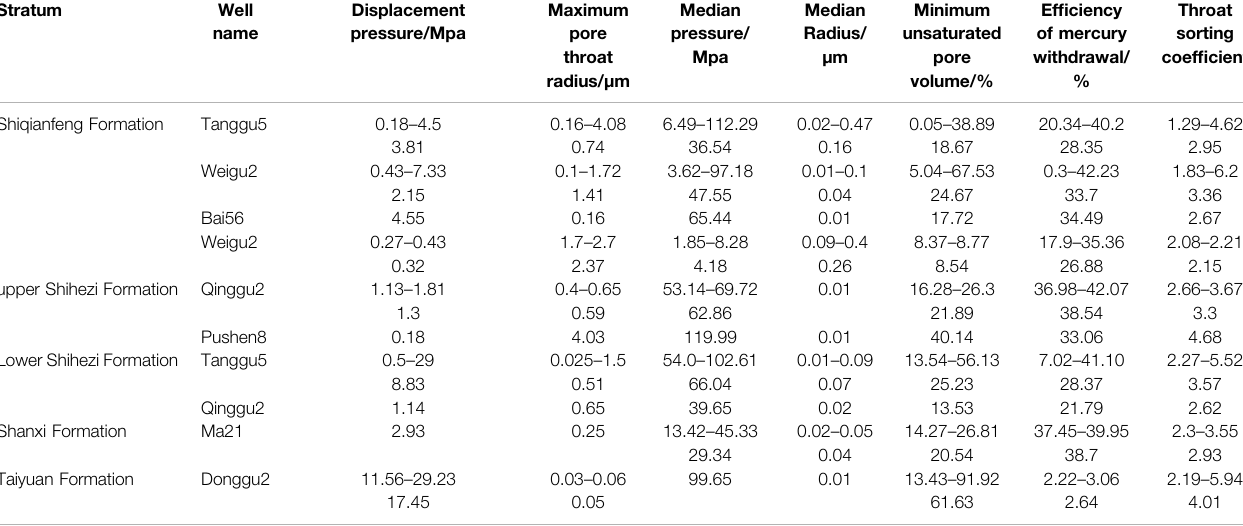
TABLE 2 | Parameters of the throat structures within the sandstone reservoirs of the Dongpu Depression (According to the Zhongyuan Oil fi eld).